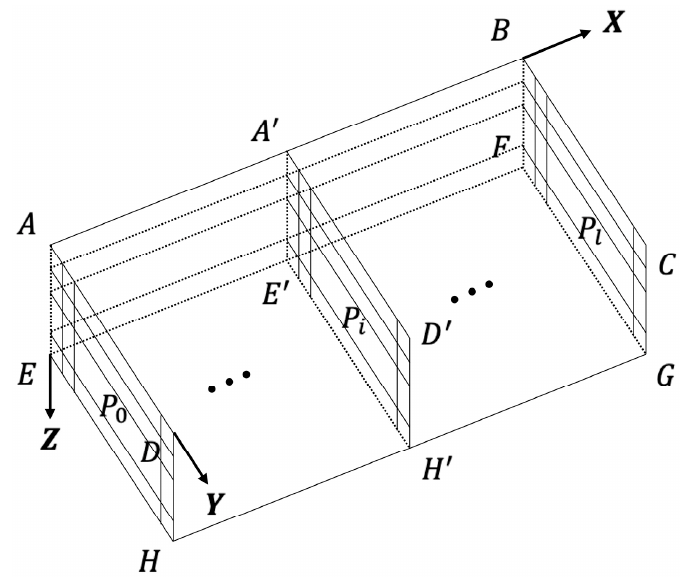
Figure 1. Environment 3D Coordinate System.